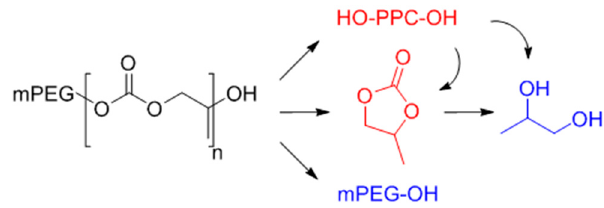
Figure 2. Degradation scheme for the acidic degradation of mPEG- b -PPC via hydrolysis (top) and depolymerization (middle). Hydrophobic (red) and hydrophilic (blue) degradation products are highlighted.